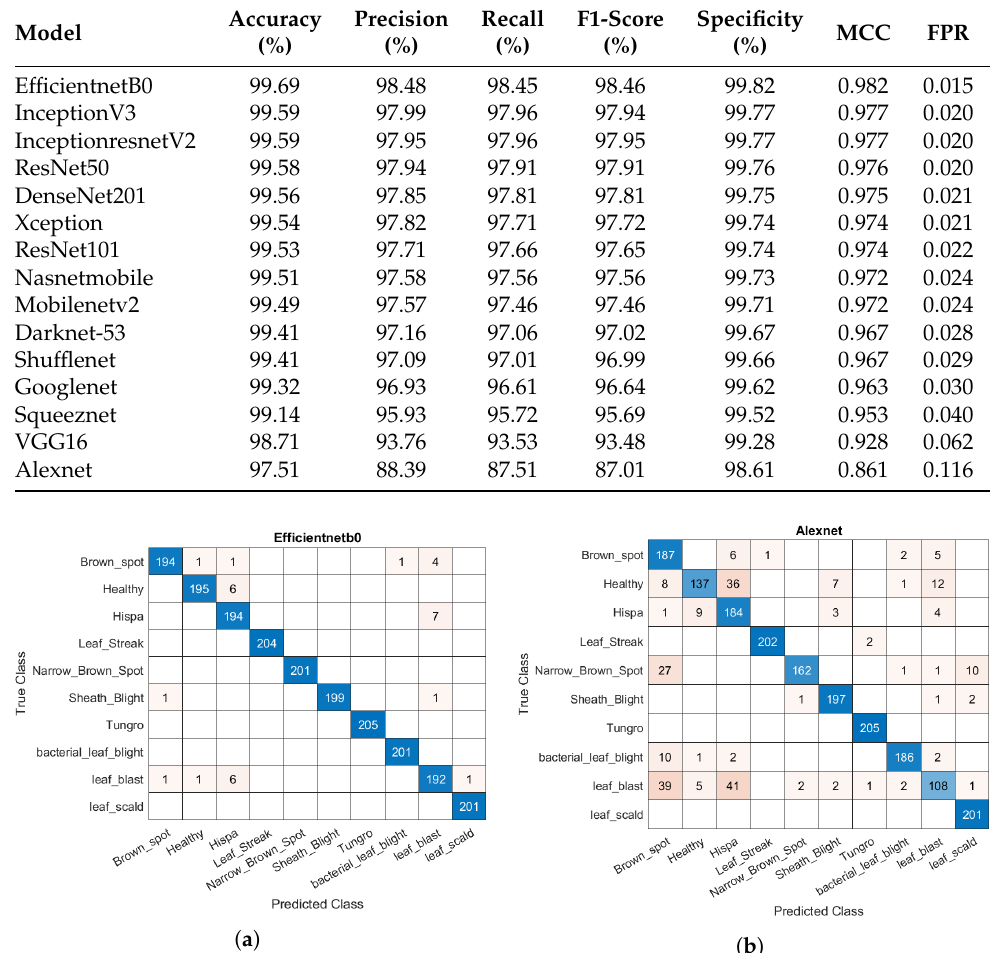
Table 8. The mean overall performance metric values using 80% of the training data.